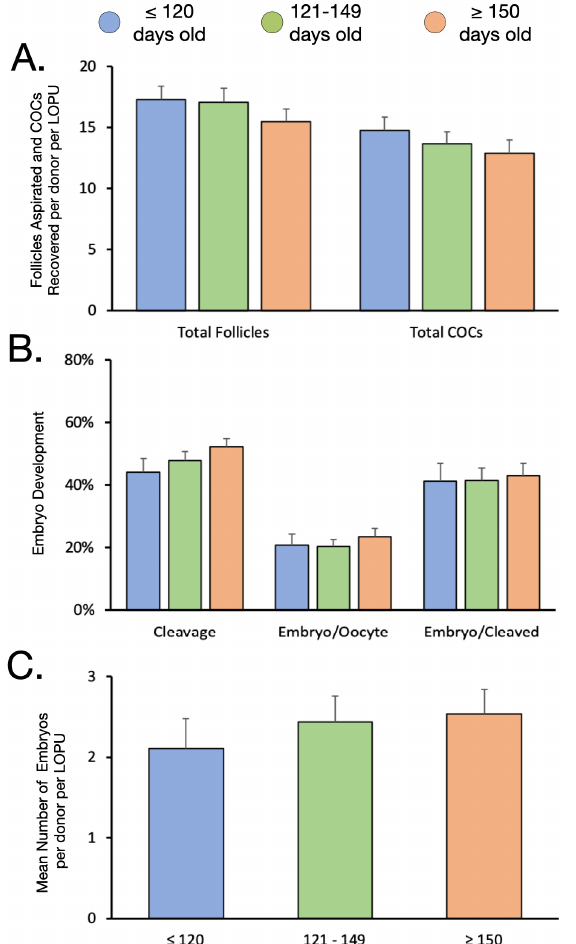
Figure 2. The effect of age on the number of follicles and COCs, embryo development rates and mean number of embryos per donor per LOPU. ( A ): LOPU results according to age showing number of follicles aspirated and number of COCs recovered. ( B ): Embryo development according to age showing cleavage and embryo development rates calculated over oocyte and cleaved embryos. ( C ): The mean number of embryos produced per donor per LOPU according to age category.